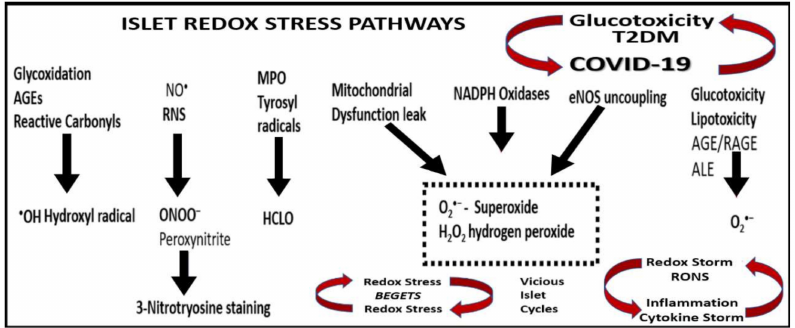
Figure 6. Islet reactive oxygen and nitrogen (nitrosative stress) species: possible pathways and enzymes responsible for the production of primary and secondary RONS in MetS, T2DM and COVID-19. The possible metabolic pathways and enzymes involved in the production of islet reactive oxygen and nitrogen (nitrosative stress) species (RONS) are illustrated. Both primary and secondary RONS are present in MetS, T2DM and COVID-19; however, it is the secondary RONS that act to produce RONS damage to tissues specifically in the pancreatic islets and consist of primary species (primary RONS), which react with one another or a transition metals (such as iron in Fenton reactions), yielding highly reactive secondary species, such as ONOO − or • OH, and may react to produce the elevated ferritin levels in Figure 1. With the abundance of redox stress and accumulation of RONS, one could consider the use of the term “redox storm”. Redox stress begets redox stress and reactive oxygen and nitrogen (nitrosative stress) species beget inflammation via NF- κ B, creating at least two vicious cycles within islets in addition to the vicious cycle between T2DM / glucotoxicity and COVID-19. AGE = advanced glycation end products; ALE = advanced lipoxidation end products; eNOS = endothelial nitric oxide synthase; H 2 O 2 = hydrogen peroxide; HCLO = hypochlorous acid; MPO = myeloperoxidase; NADPH = nicotinamide adenine dinucleotide phosphate reduced; NF- κ B = nuclear factor-kappa B; NO • = nitric oxide; RAGE = receptor for AGE; RONS = reactive oxygen and nitrogen (nitrosative stress)